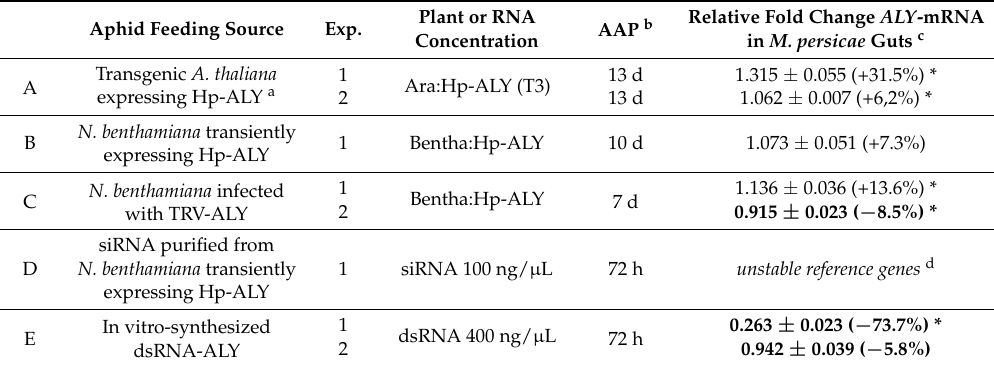
Table 4. Silencing efficiency of ALY in M. persicae guts using different RNAi-based methods. Aphid Feeding Source Exp.